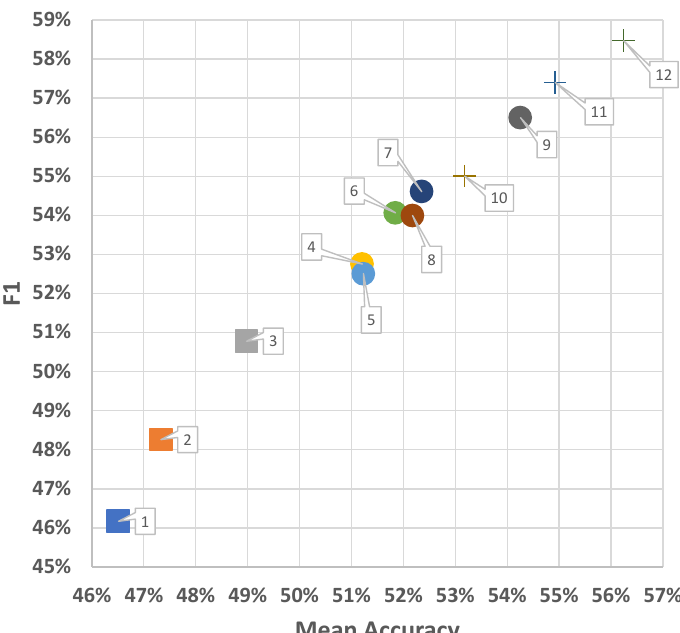
Figure 14. Results of our proposed models on the AFEW validation set. The rectangle data points represent spatiotemporal approaches, with context (Model 3) and without context (Models 1 and 2). The circular data points represent models based on temporal-pyramid approaches, which consist of two groups: without context (Models 4–6) and with context (Models 7–9) with level groups of {3}, {4}, {0,1,2,3}, respectively, in each group. Finally, the “plus sign” data points represent the average fusion method (Model 10), multi-modal joint late-fusion method (Model 11), and best selection method (Model